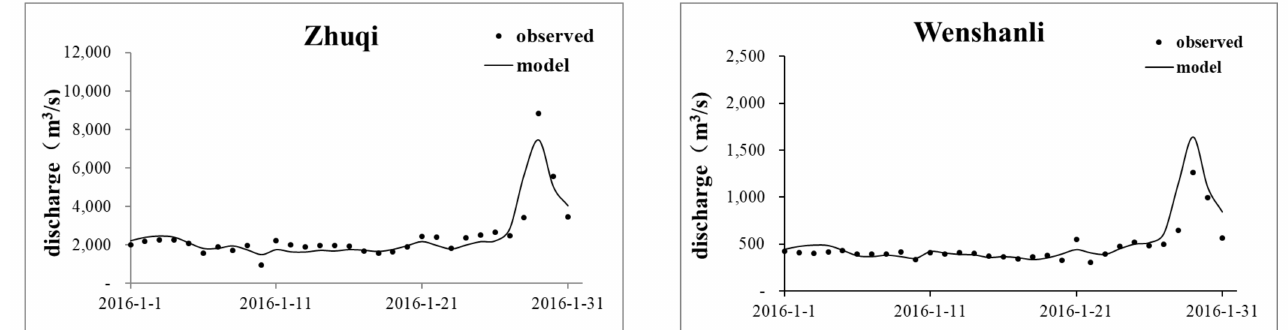
Figure 4. Flow calibration results for Zhuqi and Wenshanli.